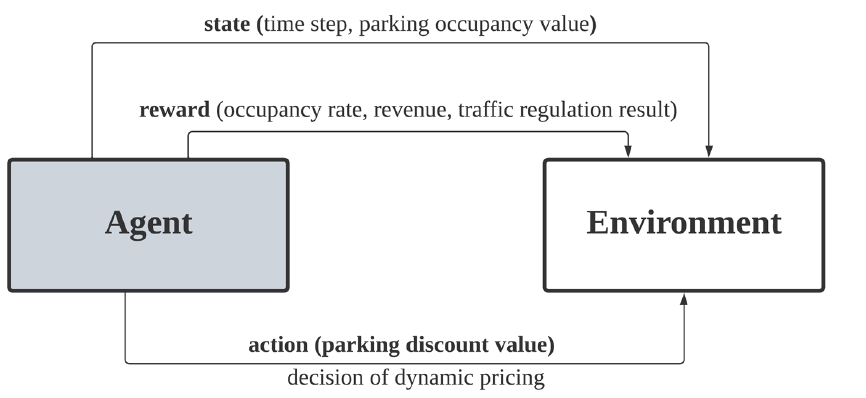
Figure 10. RL mechanism in the proposed method. Table 3. Notation of used variables in environment